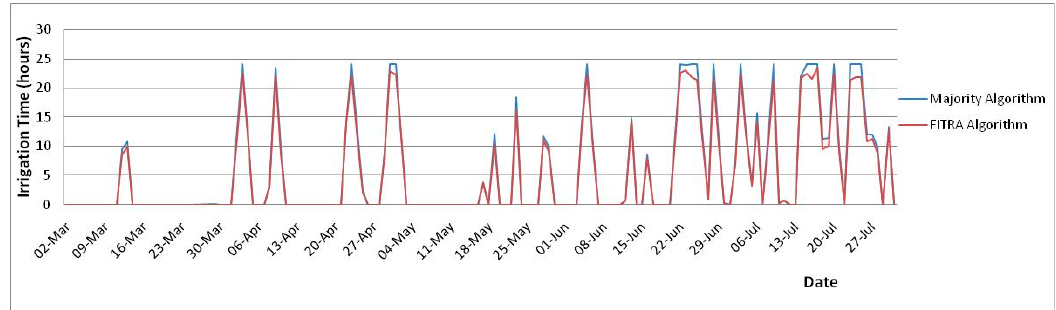
Figure 7. Irrigation time in hours per day based on the majority and FITRA algorithm.